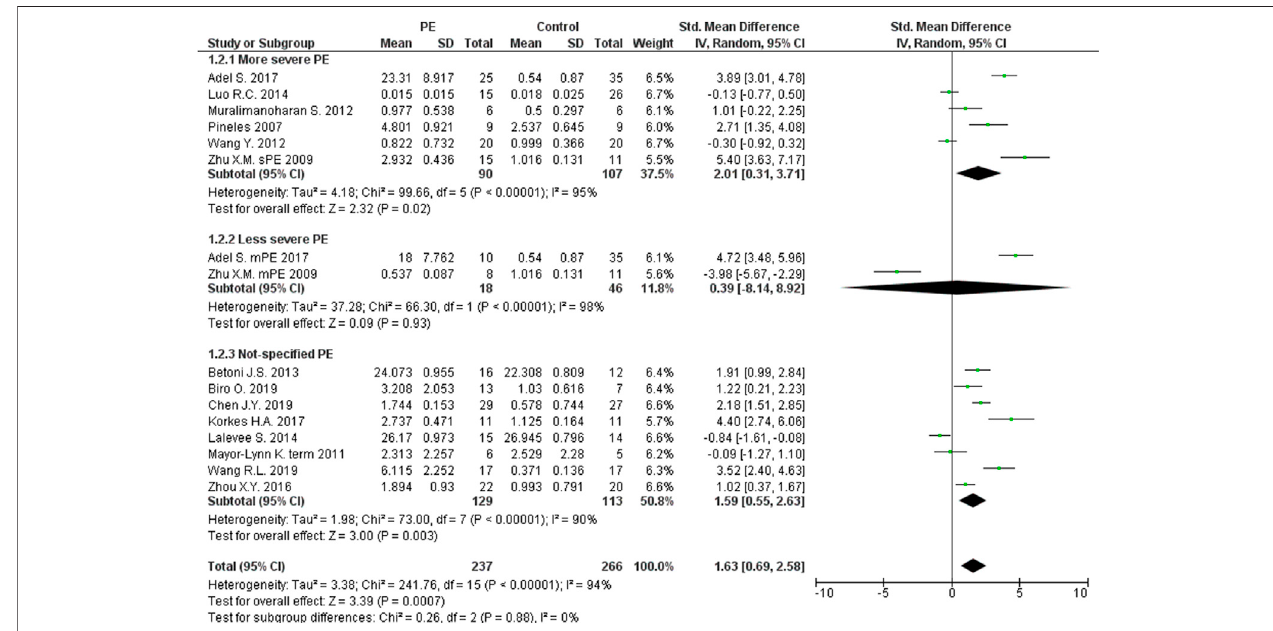
FIGURE 7 | Meta-analysis of differences in expression level of miRNA-210 in placenta between women with vs. without preeclampsia.